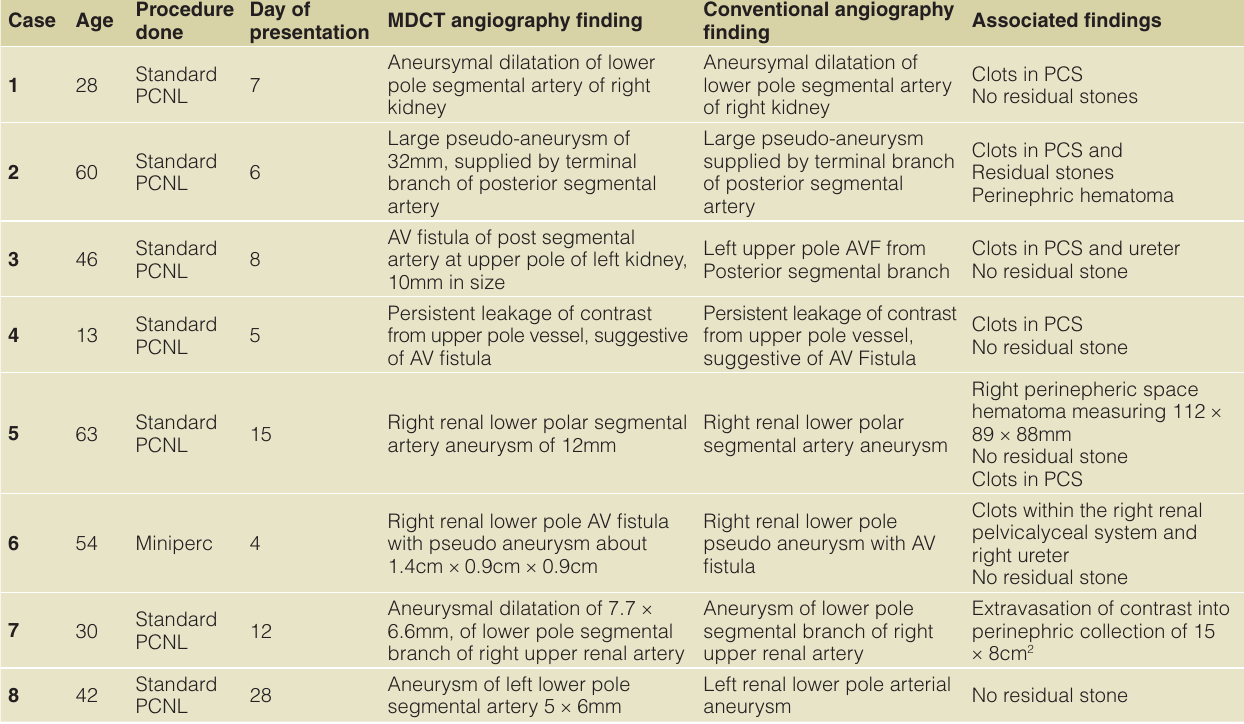
Table 1. Summary of clinical findings of patients with PCNL bleeds using MDCT and